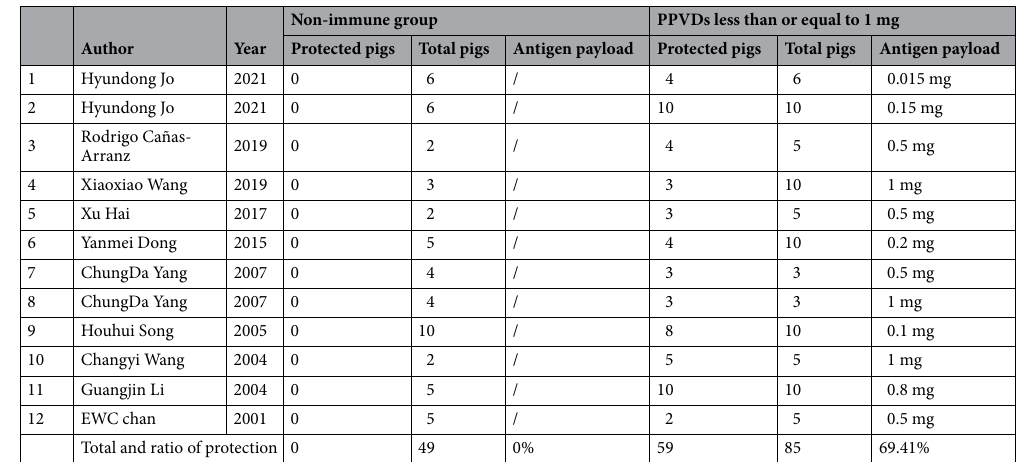
Table 2. Number of animals protected by PPVDs less than or equal to 1 mg group and the non-immune group.